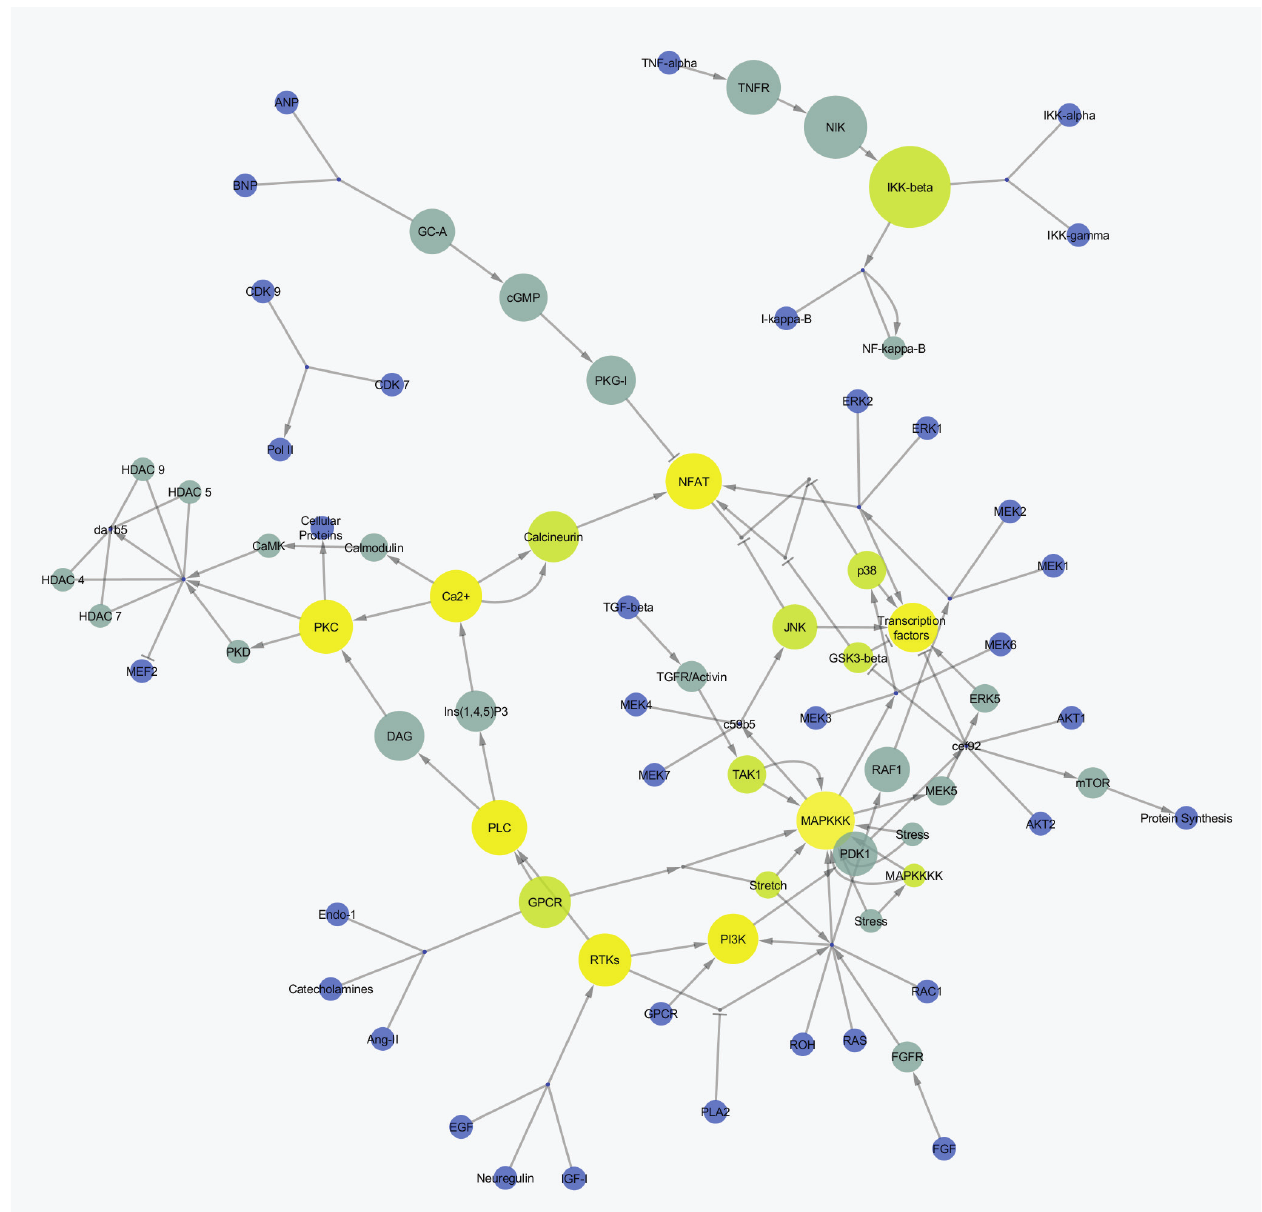
Supplementary Figure 3. Figure 2B in the WikiPathways App paper including all graphical details, e.g.